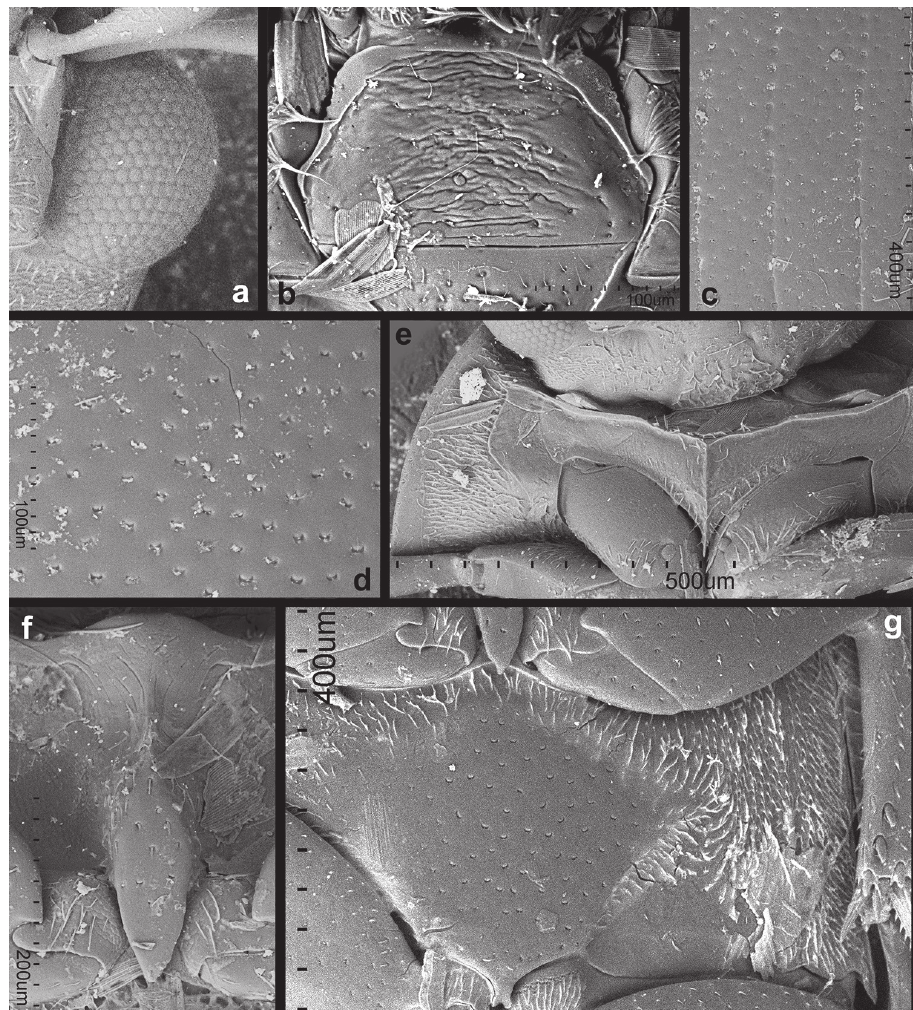
Figure 8. Cercyon ( Acycreon ) collarti d’Orchymont a ventral view of eye b labium c detail of elytral sur- face d detail of head surface e prosternum f mesoventral plate g